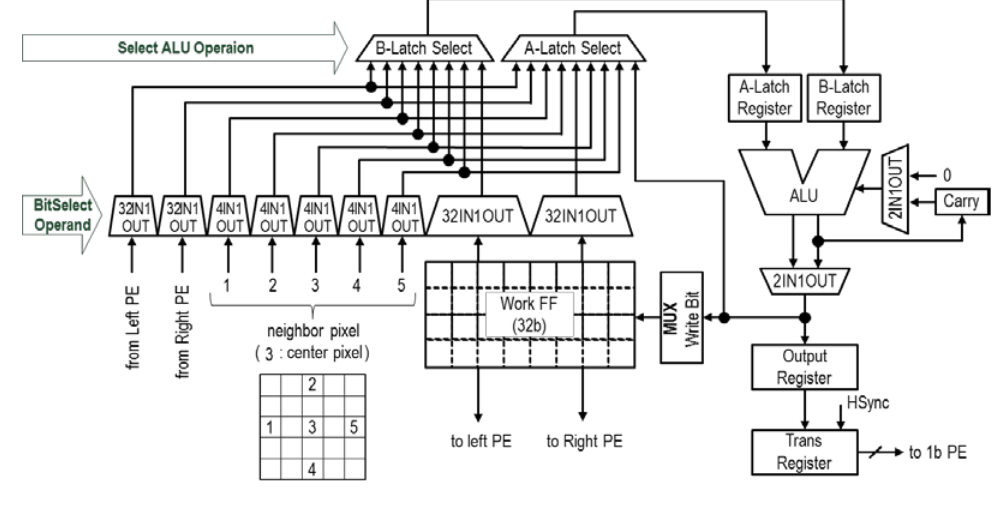
Figure 5. Schematic of the 4b PE.